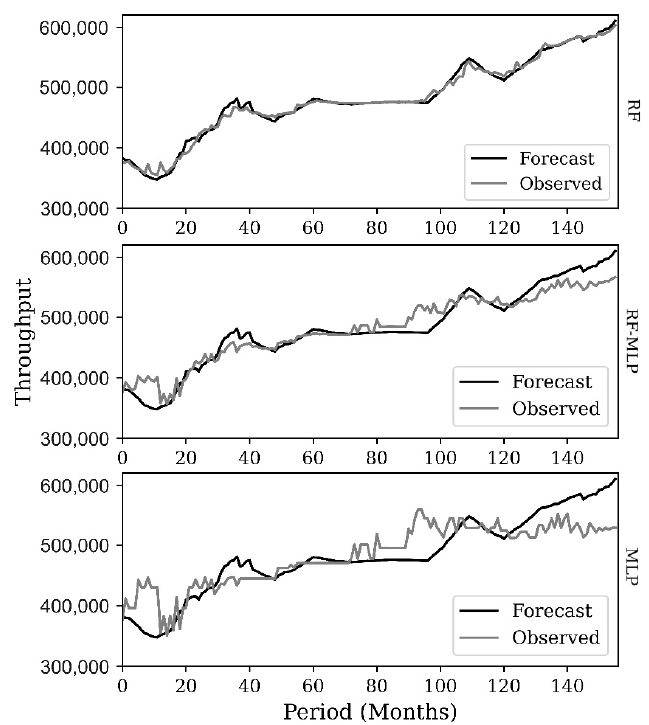
Figure 7. Comparison of predicted and observed values of performance accuracy (source: author). For comparison, the divergence of the forecasting potential between RF, RF-MLP, and MLP has been computed. From the forecast and observed values on the line plots, the RF model has the highest performance on predictions, while the hybrid model combining the random decision forest (RF) model and the artificial intelligence model (MLP) reveals slightly improved forecasting performance to the single MLP model. Thus, the RF model would provide more accurate capabilities for forecasting the optimal engineering con- tainer throughput (CT) of Douala port than RF-MLP, and MLP models. Figure 8, below, shows the future forecast of container throughput (CT) of Douala port based on the RF model, while the future forecasted indices are described on Table 3. Table 3. Monthly future forecast indices of container throuput (CT) based on the RF model. Month